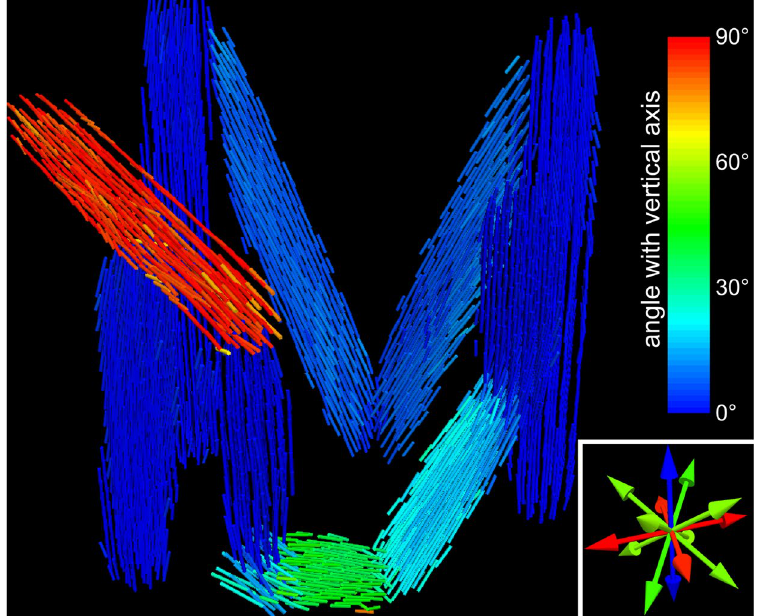
Figure 6. Visualization of the reconstructed structure orientation. From an ellipsoid fit to the scattering distribution in each voxel the smallest semi-principal axis is defined as structure orientation and visualized by little bars. Their respective colour indicates the angle between the local main structure orientation and the vertical axis. The main sensitivity orientations of the individual dark-field CT scans are shown in the